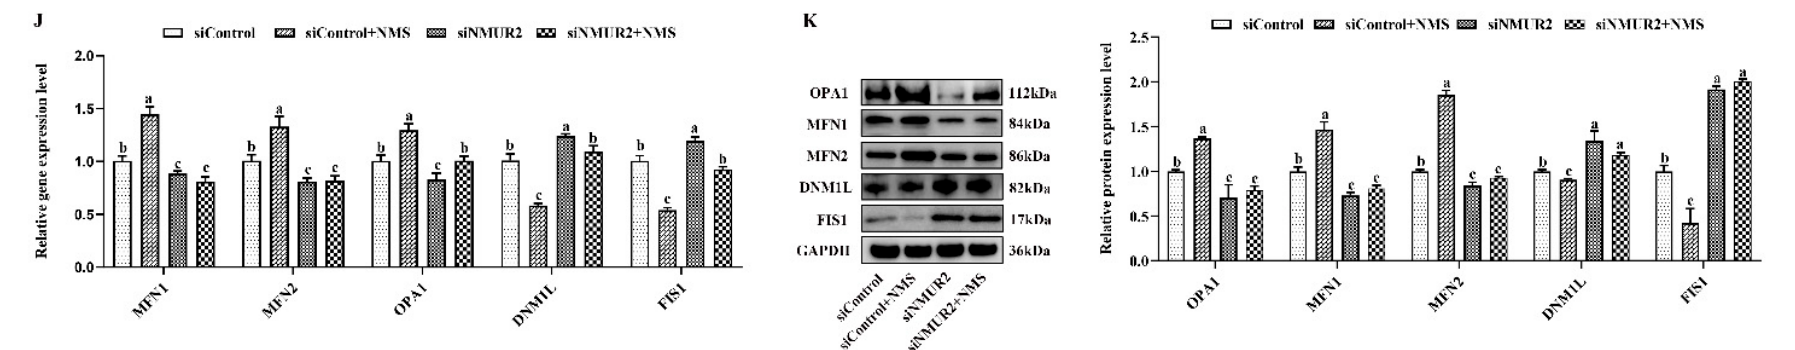
Figure 4. NMS affects mitochondrial morphology and genes related to mitochondrial quality in goat granulosa cells. ( A ) Confocal scanning image micrographs of mitochondria in goat GCs under NMS with or without siNMUR2 treatment. Mitochondria stained (red) with CMX-Ros, and nucleus (blue) stained with Hoechst 33342. ( B , C ) Statistical representation of fusion and fission mitochondria analyzed by the software. Analysis of mitochondria area ( D ), mitochondrial perimeter ( E ), mitochondrial aspect ratio ( F ), mitochondrial form factor; mitochondrial form factor is calculated as (perimeter2)/(4 π · surface area) and reflects the complexity and branching aspect of mitochondria ( G ). ( H ) Representative electron micrographs of mitochondria in goat GCs under NMS with or without siNMUR2 treatment; a1–d1 are enlarged images of a–d; arrowheads indicate mitochondria. ( I ) Electron micrographs of the mitochondrial cristae and quantification of cristae density in goat GCs under NMS with or without siNMUR2 treatment. Arrowheads indicate mitochondrial cristae changes. The number of cristae was counted for each mitochondrion and divided by the mitochondrial area in megapixels. Four to twelve mitochondria were analyzed in each cell. n = 32, 31, 29, and 27 in siControl, NMS, siNMUR2 and NMS + siNMUR2 groups, respectively. ( J ) The mRNA expression of genes related to mitochondrial dynamics was determined by qPCR. ( K ) The protein expression of genes related to mitochondrial dynamics was determined by Western blot. Data are representative of at least three independent experiments. Different letters indicate significant differences in the expressions between the groups ( p < 0.05).